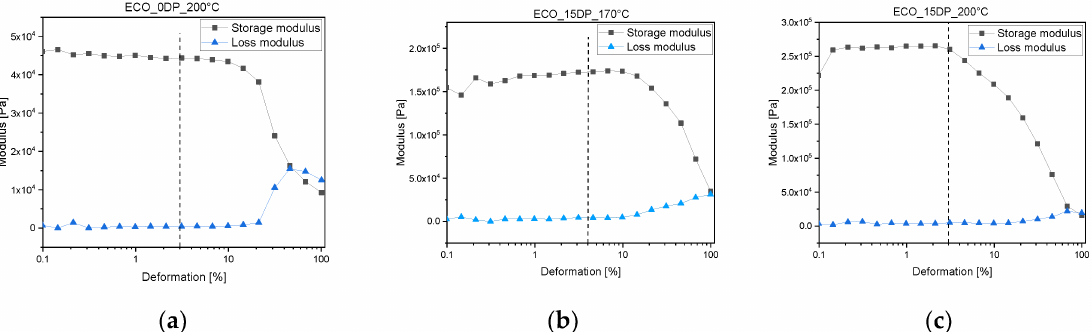
Figure 5. Amplitude sweep tests of pristine ECO UV-cured samples with no catalyst at 200 ◦ C ( a ), ECO UV-cured samples containing 15 phr DP at 170 ◦ C ( b ), and ECO UV-cured samples containing 10 phr at 200 ◦ C ( c ).